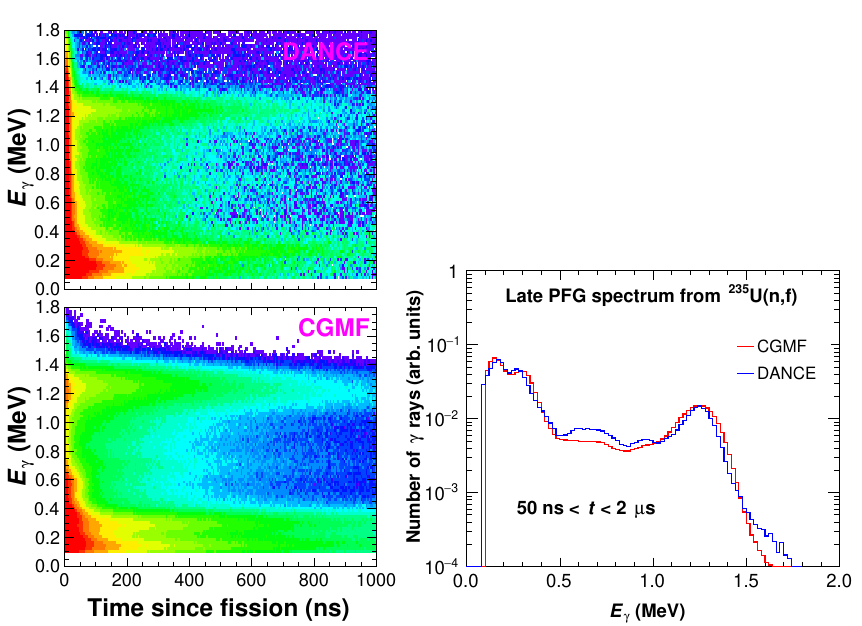
Figure 5. Measured γ -ray spectrum of the late PFG from the 235 U( n , f ) reaction as a function of the time since fission (top-left panel). CGMF calculations for the same reaction folded with the DANCE detector response (bottom-left panel). Integrated experimental and theory spectra from 50 ns to 2 µ s and normalized to unity (right).